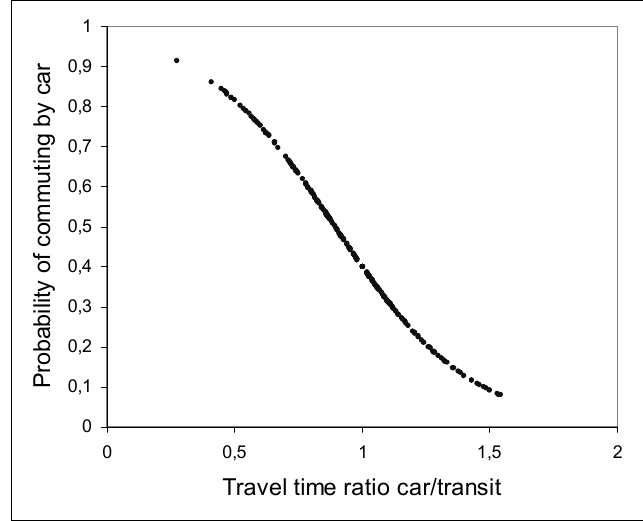
Figure 8. Probability of commuting by car at varying ratios of door-to-door travel times by car and transit. N=261 commuters living in western suburbs of Oslo and working in the downtown area. The probability levels apply to male respondents holding a driver(cid:237)s license, with a high car-ownership level and good parking conditions at the workplace. The following variables have been kept constant at mean values: income level, education level, age, travel expenses paid by the employer, and errands on the way home from work. Sig. = 0.0000. Source: Naess, Sandberg and Mogridge (2001) was 20 per cent faster than transit, the probability of going by car was 59 per cent. Increased road capacity leading in a short term to better-flowing traffic is therefore likely to change the modal split in favour of the least energy-efficient mode. In a longer term, congestion is likely to occur again (Mogridge, 1997). The low average probability of commuting by car among the respondents must be seen in the light of the fact that the workplaces were all located in the downtown area of Oslo, cf. also Figure